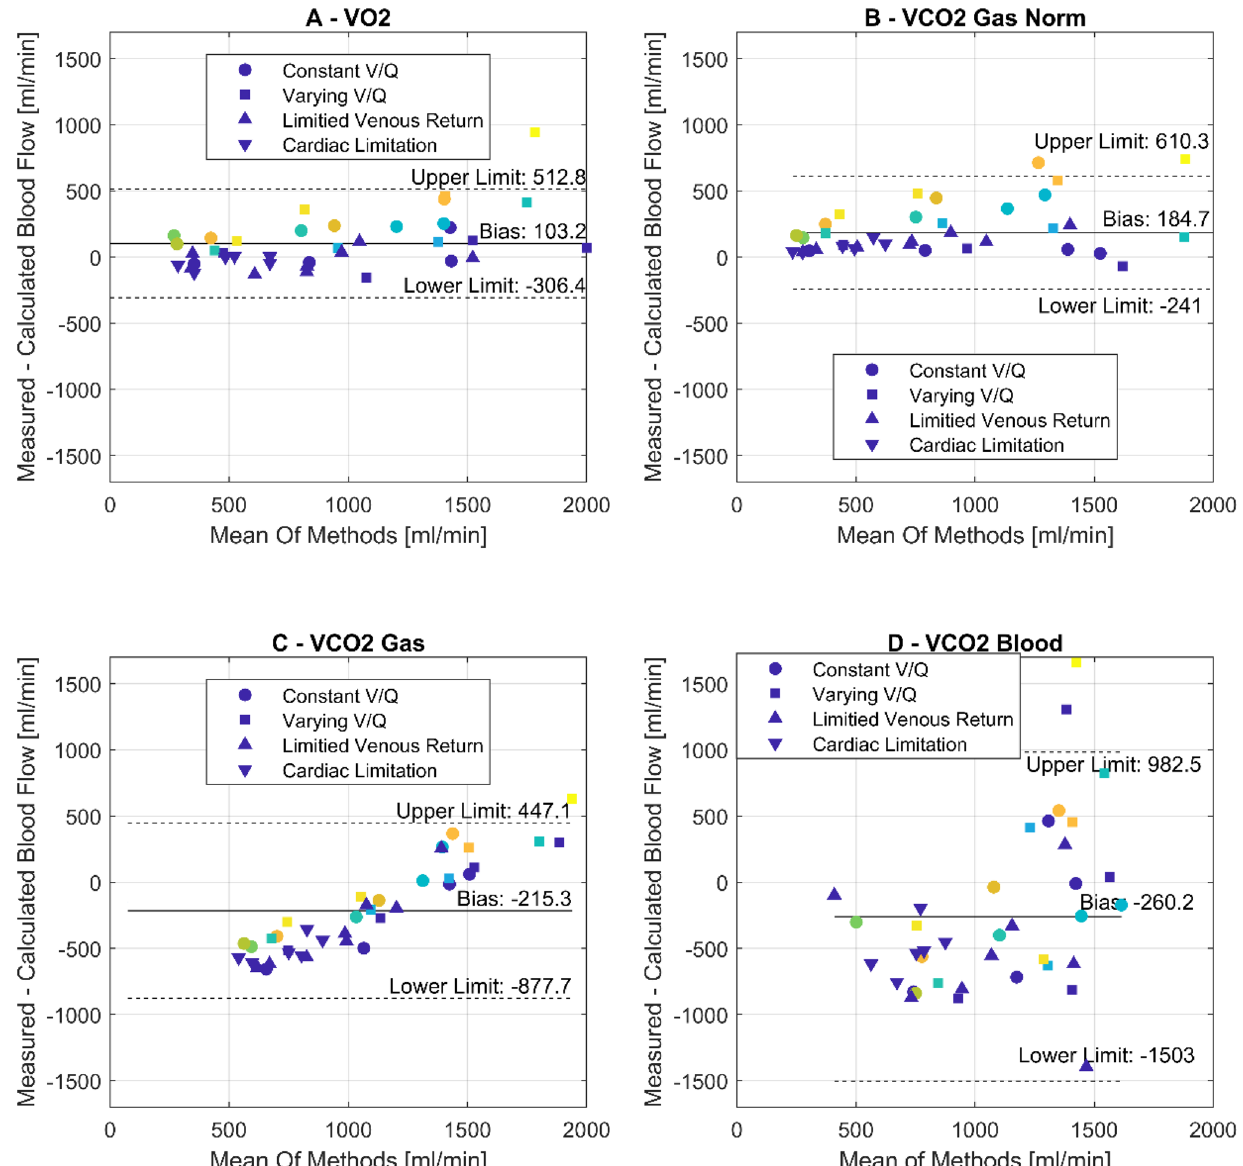
. . V O V CO . 2 ( A ), 2GasNorm normalized for ECMO and Lung to a V CO 2Blood ( D ). Mean and upper/lower are depicted